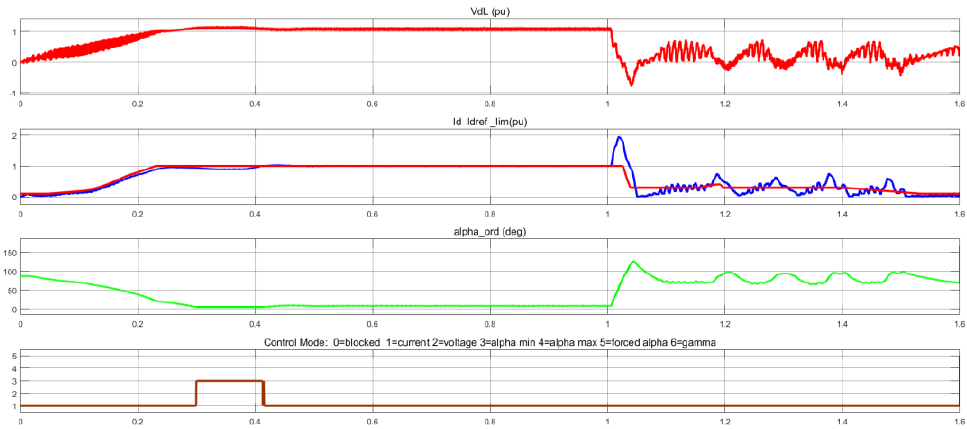
Figure 10. The voltage and the current signal, and alpha order.